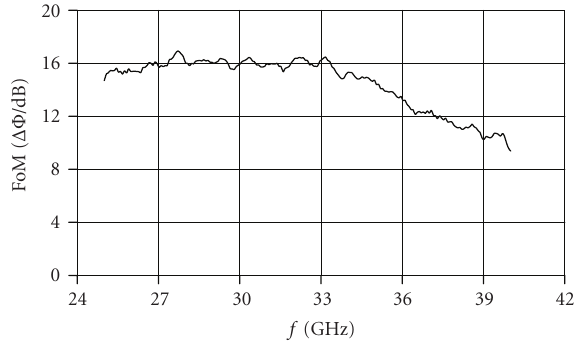
Figure 9: FoM of the LTCC phaseshifter.